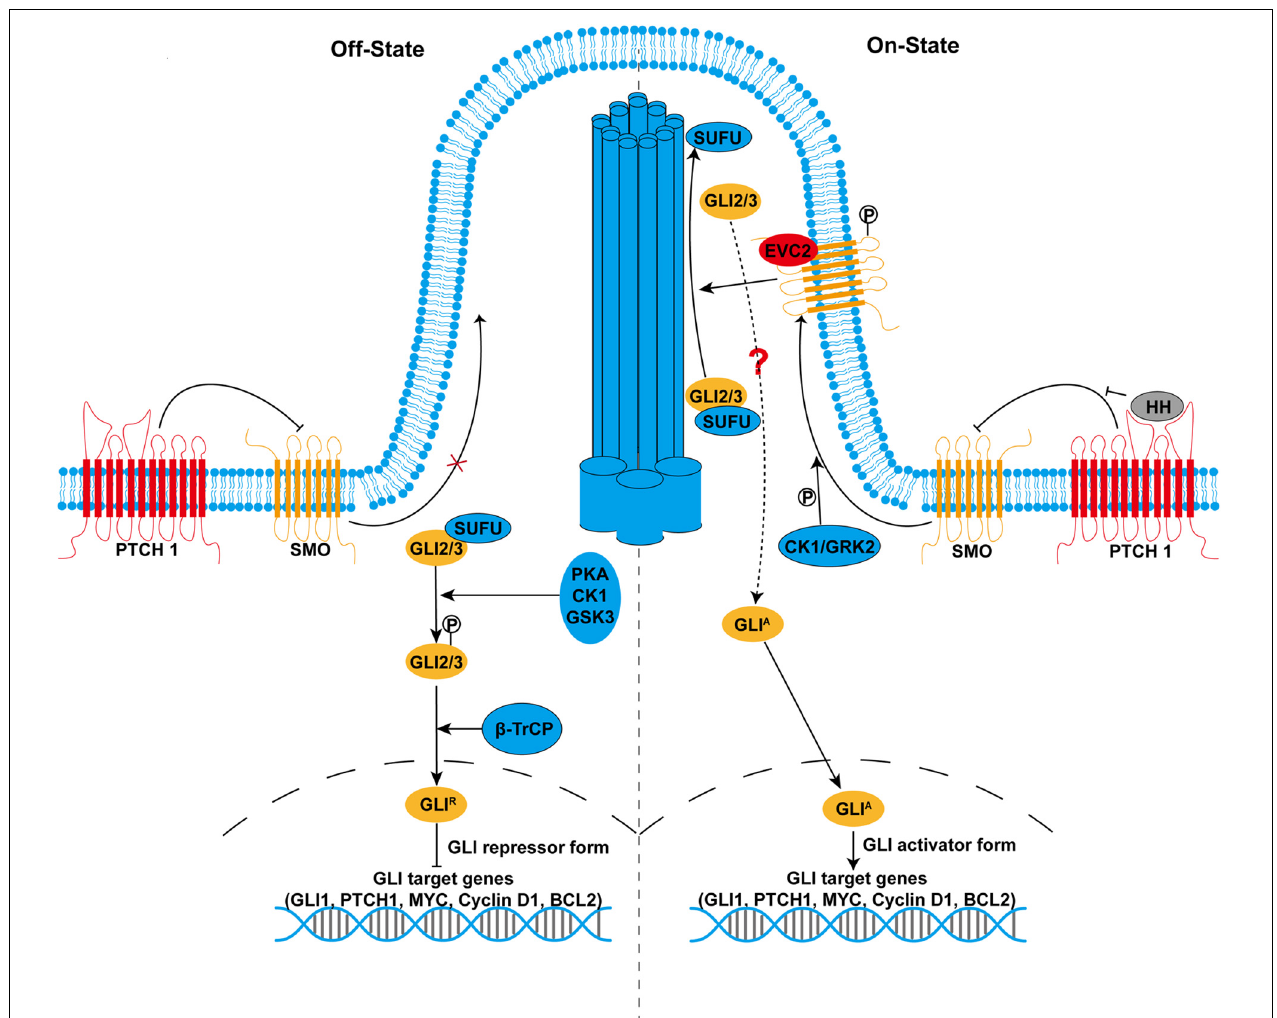
FIGURE 1 | The hedgehog (HH) signaling pathway in mammals. In the absence of HH ligands (left side) , smoothened (SMO) is inhibited by primary cilium-localized Patched 1 (PTCH1). With the inactivated SMO, full-length GLI2 and GLI3 (GLI2/3) are retained in the cytoplasm by suppressor of fused (SUFU) and phosphorylated by protein kinase A (PKA), casein kinases 1 (CK1), and glycogen synthase kinase 3 (GSK3). Phosphorylated GLI2/3 are proteolytically processed by E3 ubiquitin ligase β -transducin repeat-containing protein, resulting in the production of the repressor form GLI R , which enters the nucleus to suppress the transcription of target genes. In the presence of HH ligands (right side) , binding of HH to PTCH1 derepresses SMO. SMO is phosphorylated by CK1 and GRK2 and translocates to the primary cilium. Activated SMO not only inhibits proteolytic processing of GLI2/3 but also promotes the recruitment of GLI2/3-SUFU complex to the tip of the primary cilium, leading to their dissociation and production of the activator form GLI A , a process that might involve Ellis-van Creveld/EVC2. GLI A enters the nucleus as transcription activators and promotes the transcription of target genes that are important for many cellular processes, including cell proliferation, differentiation, survival, and maintenance of